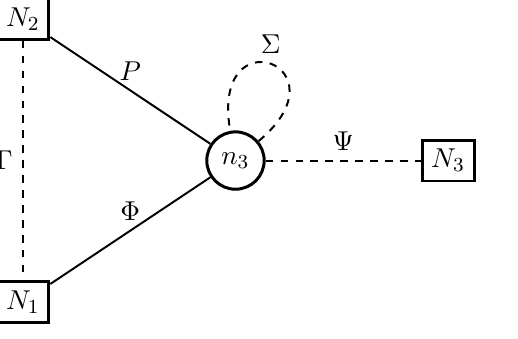
Figure 1 . The quiver diagram for our 2d (0 ; 1) SQCD with gauge group SO( n 3 ). Each solid line represents a 2d (0 ; 1) scalar multiplet, whereas a dashed line represents a Fermi multiplet.